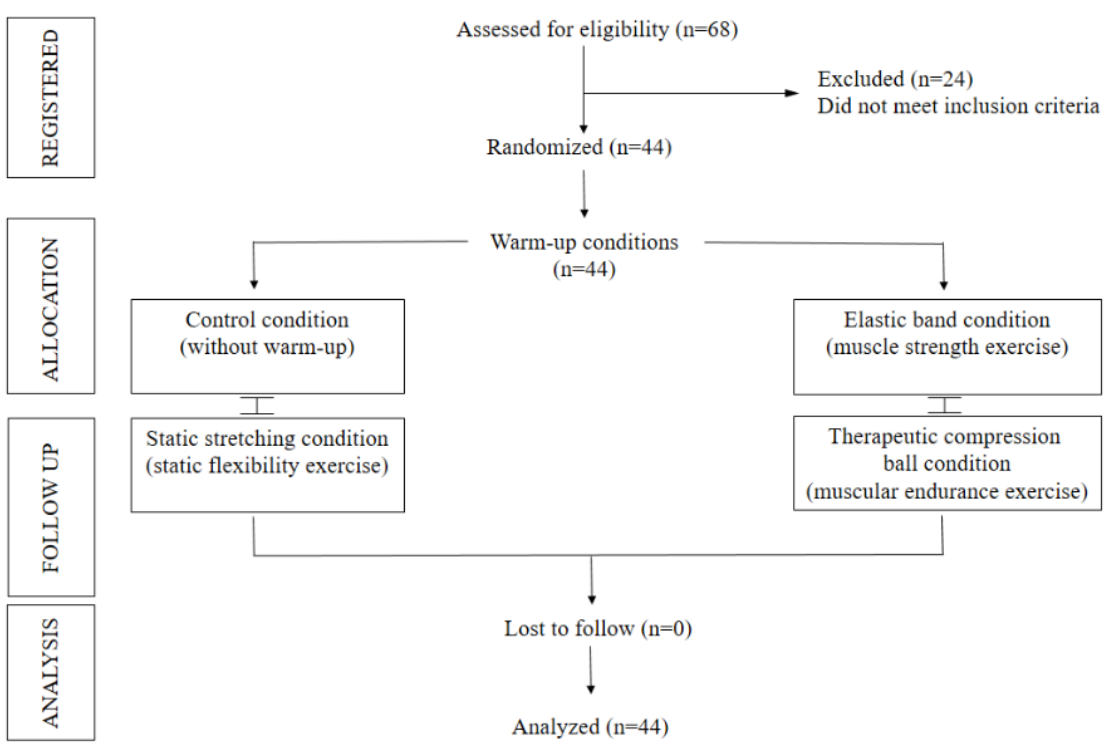
Figure 1. Flowchart of the recruitment process.